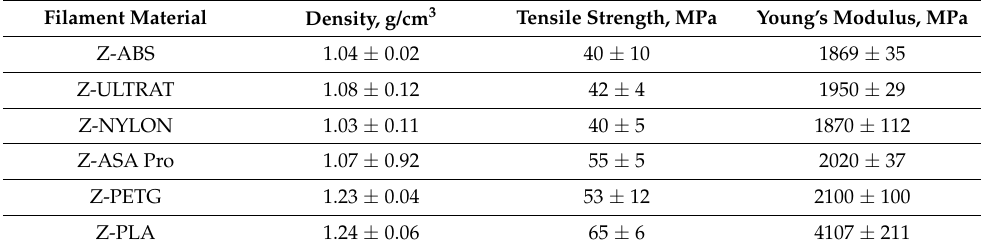
Table 2. Measured mechanical properties of commercial 3D printing